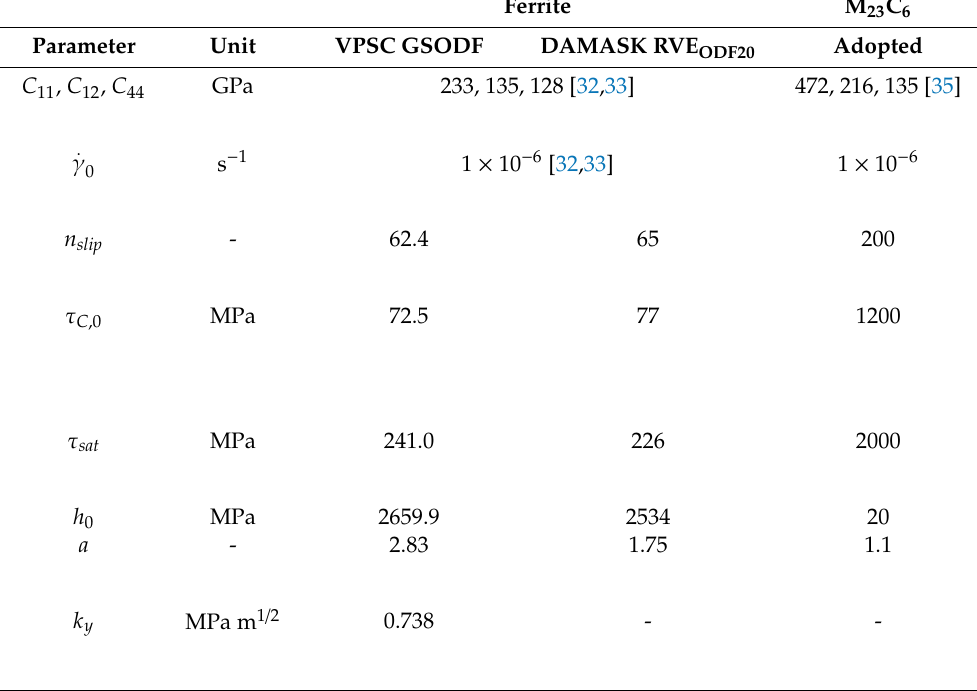
Table 1. Adopted and calibrated material parameters for ferrite and M 23 C 6 carbides. The parameters fitted for Visco Plastic Self Consistent (VPSC) correspond to the average grain size ( τ s c Equation